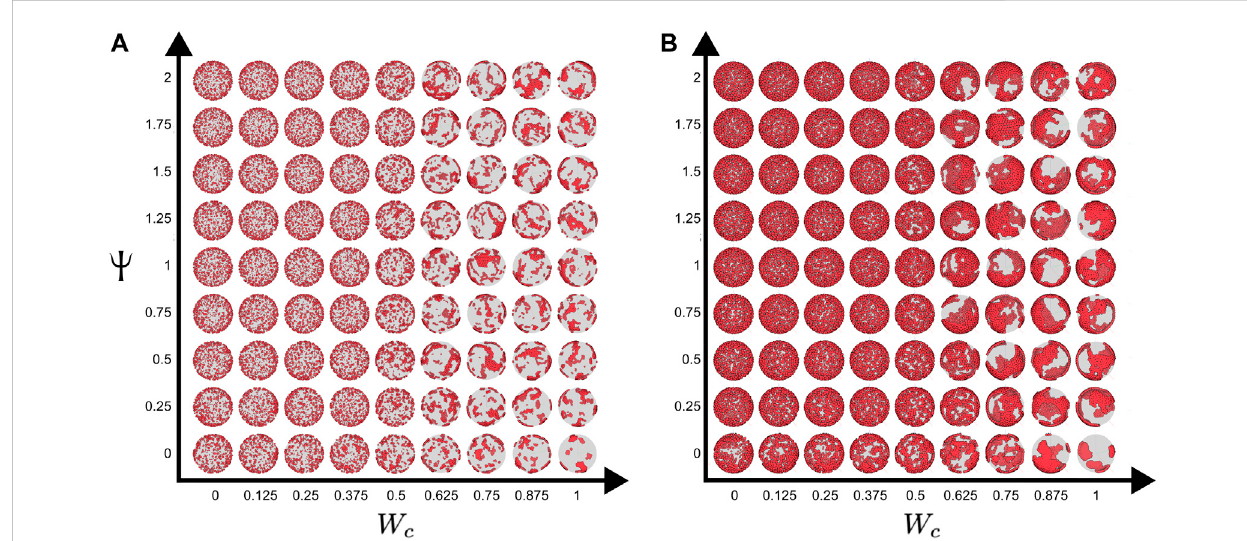
FIGURE 4 Parameter scan of the cell-autonomous system over different cell adhesion and CIL parameters. (A) Cell density of ϕ (cid:1) 0.2 (500 cells on a sphere of radius 25). (B) Cell density of ϕ (cid:1) 0.56 (500 cells on a sphere of radius 15). The dispersed states are maintained at low cell – cell adhesion, and clustering is increased by high cell – cell adhesion. High levels of CIL ( Ψ ) also increase cell clustering at moderate levels of cell – cell adhesion. The YSL is drawn as a transparent gray sphere; hence, the cells on the far side appear darker. The three-dimensional perspective means that these cells also appear smaller.